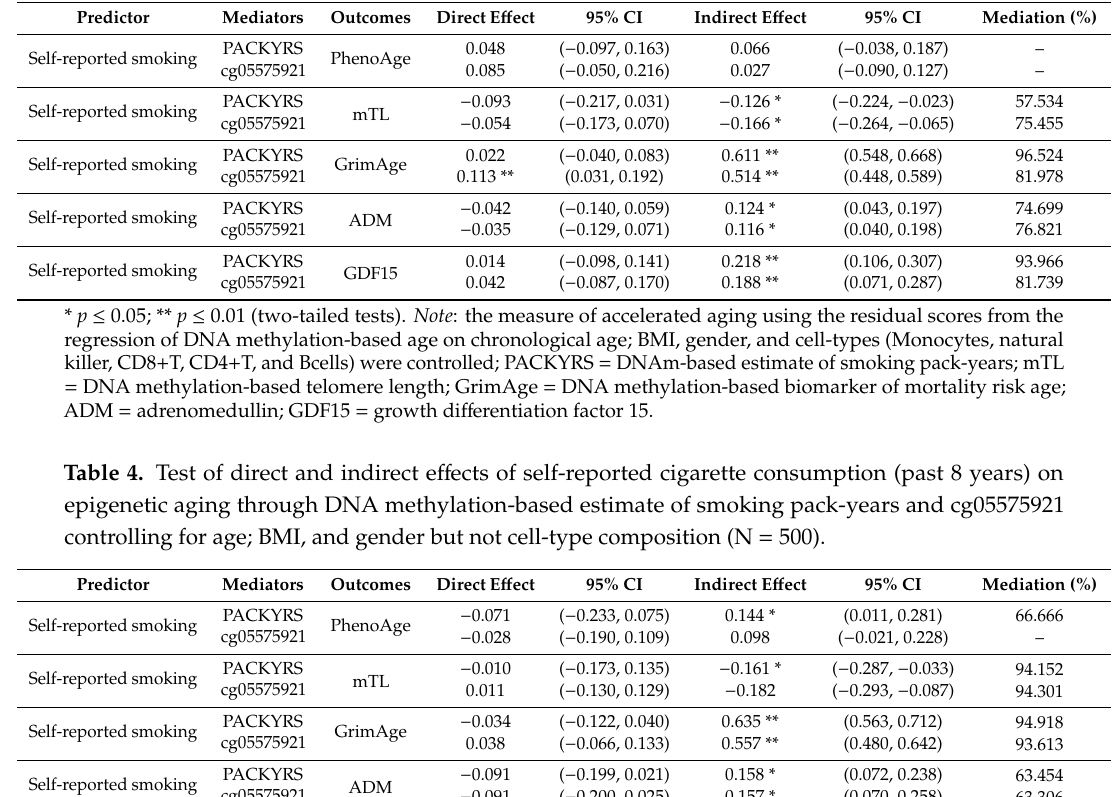
Table 3. Tests of direct and indirect e ff ects of self-reported cigarette consumption (past 8 years) on DNA methylation-based aging indices through DNA methylation-based estimate of smoking pack-years and cg05575921, controlling age; BMI, gender, and cell-types ( N = 500).